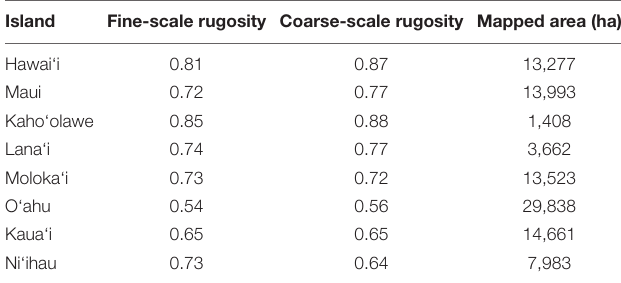
TABLE 3 | Mean fine-scale and coarse-scale rugosity, and the total reef mapping area, of each island in the Main Hawaiian Islands.